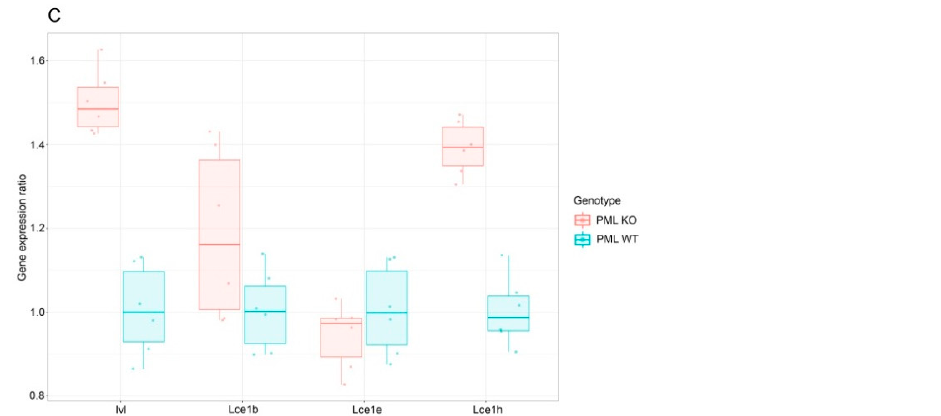
Figure 2. PML controls expression of the cornified envelope genes. ( A ) Graphs depicting di ff erentially expressed cornified envelope genes. Left panel shows data from RNA-seq analysis. Right panel shows a comparison of data obtained from RNA-seq (stapled lines) and RT-qPCR (solid lines), respectively. ( B ) Box plots showing di ff erential expression of selected genes from the cornified envelope region of the EDC gene locus by RT-qPCR analysis of PML-wt and PML-KO extracts. Di ff erential expression at di ff erent time points during embryonic and postnatal development is shown. Each data point (dot) in box plot represents a single embryo. ( C ) Keratinocytes were isolated from the epidermis of PML-wt and PML-KO mouse embryos (stage E18.5) and subsequently passaged in culture. RNA was extracted from the cultured cells and selected genes from the cornified envelope region of the EDC gene locus were subjected to analysis by qPCR. Box plots show di ff erential gene expression of selected genes. Each data point (dot) in box plot represents a single embryo.